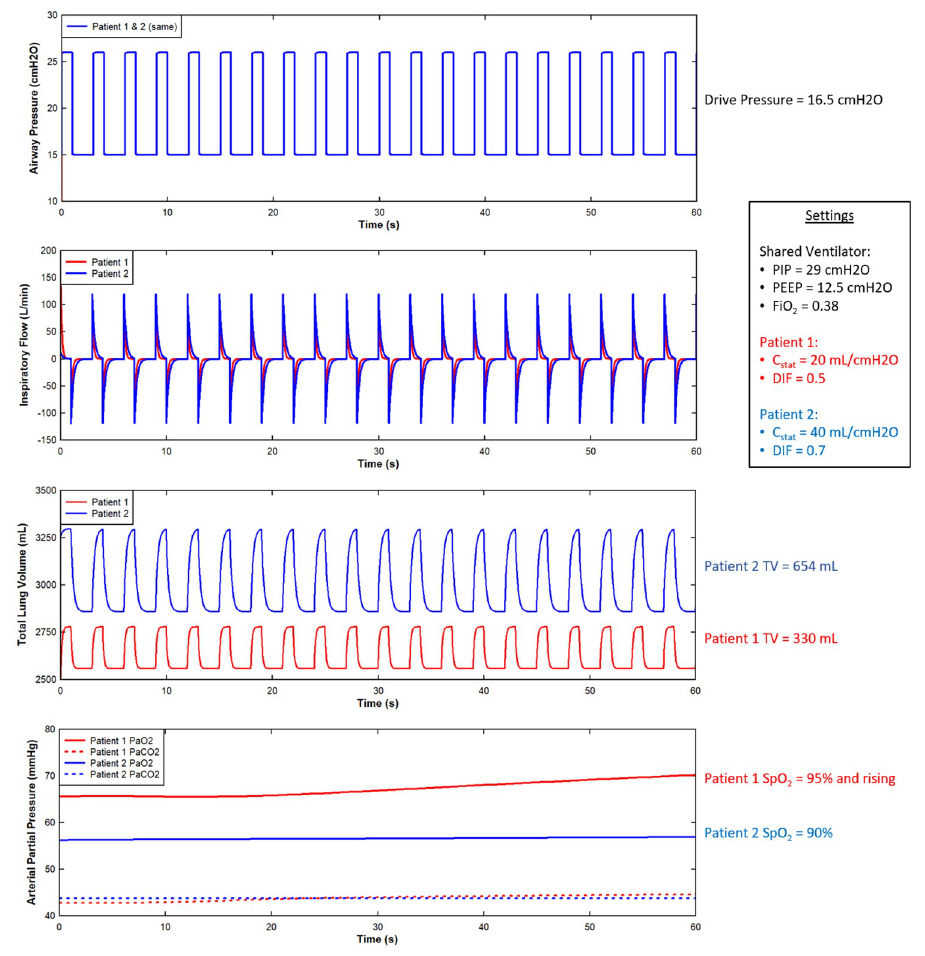
bounds for lung protective